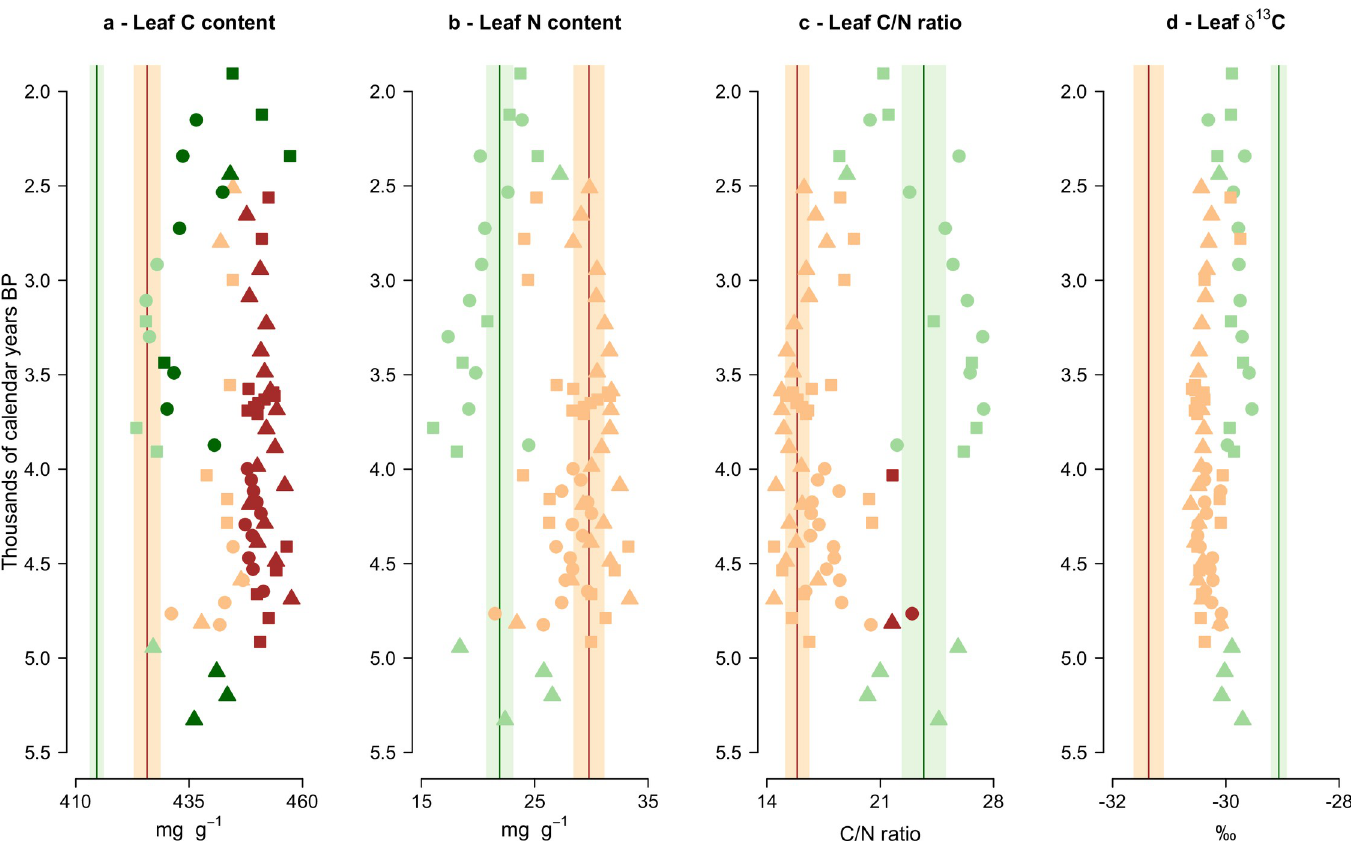
Fig 4. Changes in trait community weighted means (CWMs) through time (in thousands of calendar years before present) of the Holocene pollen-derived leaf trait records from three Romney Marsh sites (circles = Brookland; triangles = The Dowells; squares = Hope Farm). Green and brown symbols indicate the predominance of herbaceous and woody taxa in the Holocene record, respectively. The means of the modern vegetation (i.e., plant-based data) are shown for herb (green vertical lines) and woody (brown vertical lines) fens. Shaded areas around the modern means depict their 95% confidence intervals. Darker-coloured symbols show Holocene samples significantly different from their equivalent (herbaceous or woody) modern vegetation means at p < 0.05 (one-observation t